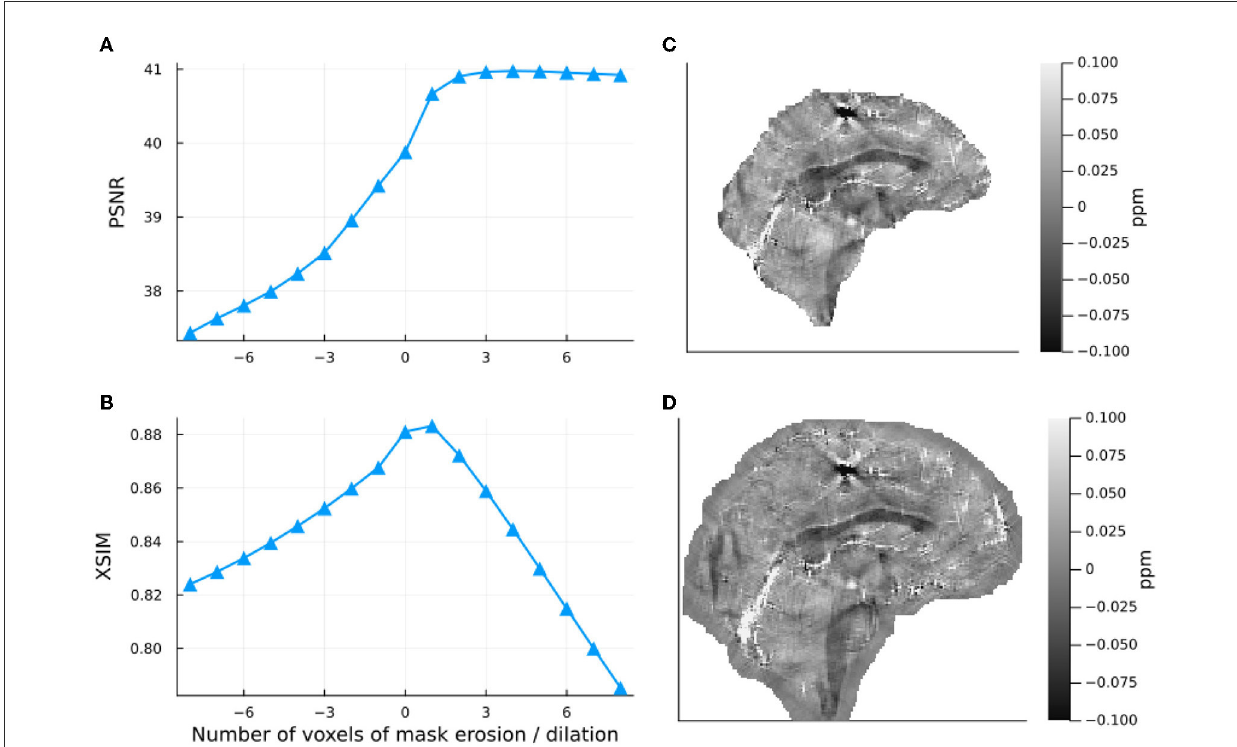
FIGURE5 Effect of dilation and erosion of the brain mask or image support S χ on the incomplete spectrum QSM reconstructed in the numerical phantom. Input data were masked with the same mask S χ as that used in the reconstruction. On the left-hand side, PSNR (A) and XSIM (B) values are plotted for masks eroded and dilated by different numbers of voxels. The right-hand side shows incomplete spectrum QSM reconstructions with a mask eroded by 5 voxels (C) and a mask dilated by 5 voxels (D)